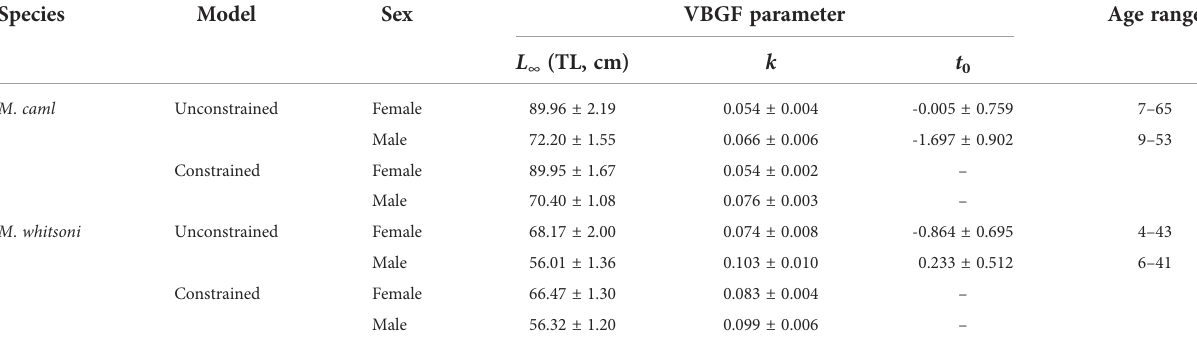
TABLE 3 von Bertalanffy growth function (VBGF) parameter estimates ± standard error for unconstrained and constrained ( t 0 = 0) models and observed age ranges for Macrourus caml and M . whitsoni in the Ross Sea region.